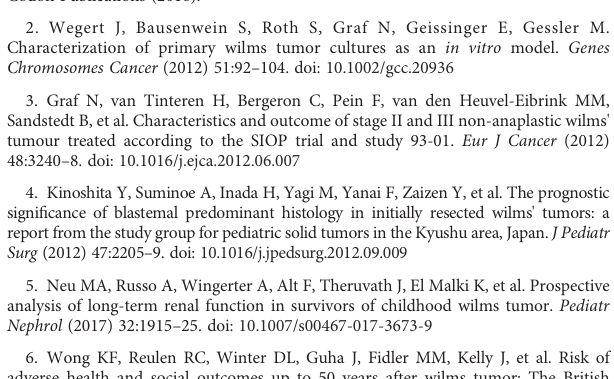
SUPPLEMENTARY FIGURE 1 Scatter plots of fl ow cytometric quanti fi cation for SIX2+ VUWT13 and VUWT50 cultured and passaged cells. Controls included only secondary antibody for proper gating. SUPPLEMENTARY FIGURE 2 A composite graph of fl ow cytometric analyses of SIX2 expression in all passages of cultured VUWT22, VUWT34, and VUWT54 cells. SUPPLEMENTARY FIGURE 3 Analysis of ALDH1+ cells for cultured passages of VUWT34 and VUWT54 cells using fl ow cytometry. SUPPLEMENTARY FIGURE 4 Immunoblot analyses for Wilms tumor markers in cultured passages of VUWT22, VUWT34, and VUWT54 cells. SUPPLEMENTARY FIGURE 5 Immunoblot analyses for Wilms tumor markers in spheroids from various cultured passages of; A - VUWT22, B - VUWT34, and C - VUWT54 cells. VUWT13 and VUWT50 were taken from these blots and included in Figure 6. HEK293 and embryonic mouse kidney were used as